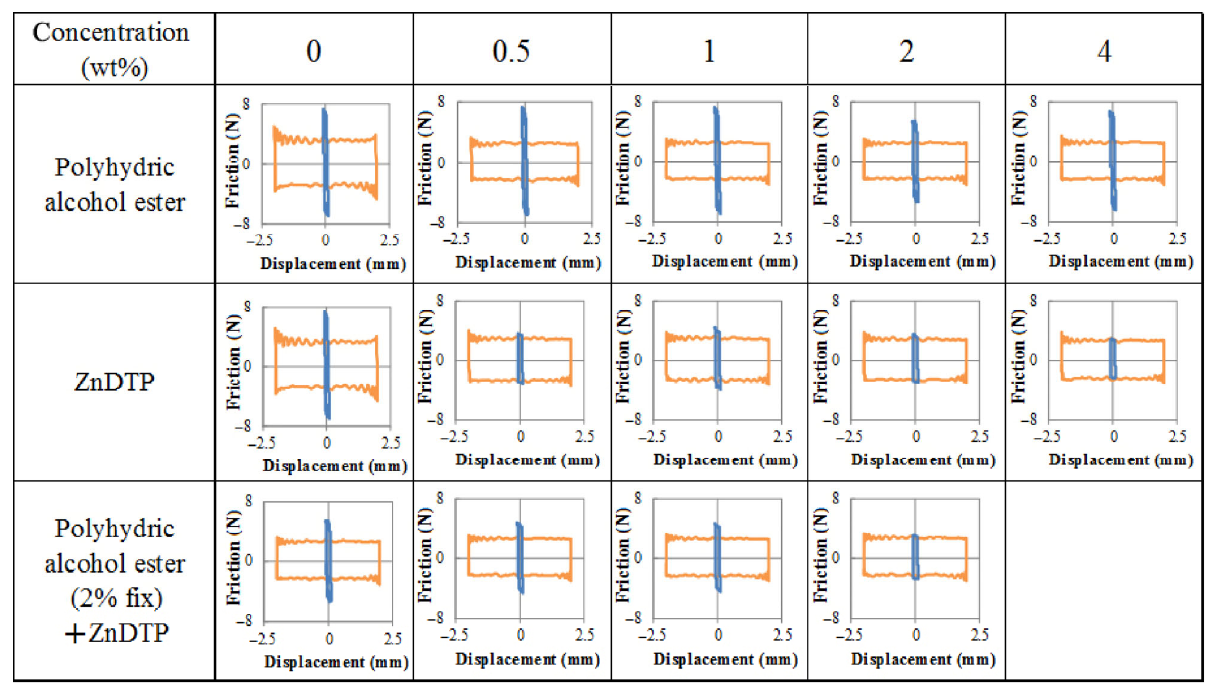
Fig. 7 Friction waveform results for each hydraulic